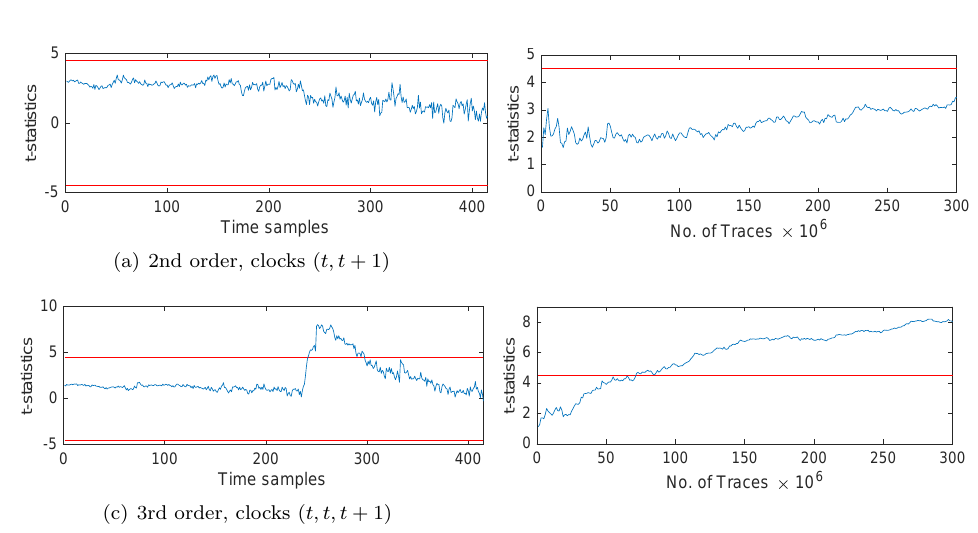
Figure 7: Multivariate non-specific t -test results with 300 million measurements for a single GF (2 4 ) multiplier masked by means of CMS with d = 3. The left column depicts the t -values over time, the right column illustrates the evolution of the absolute maximum t -value over the number of